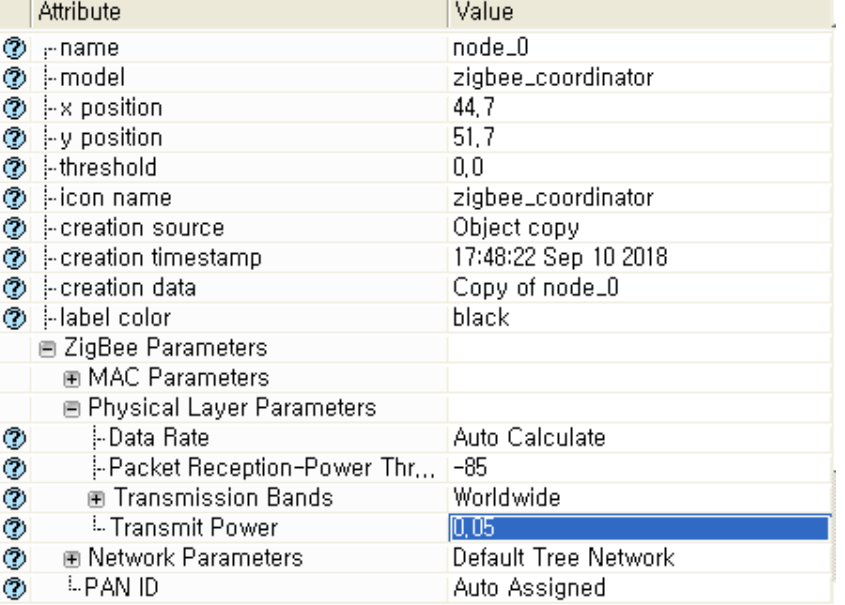
Figure 5. The Blue Line (all the transmission power outputs were set at 0.05).